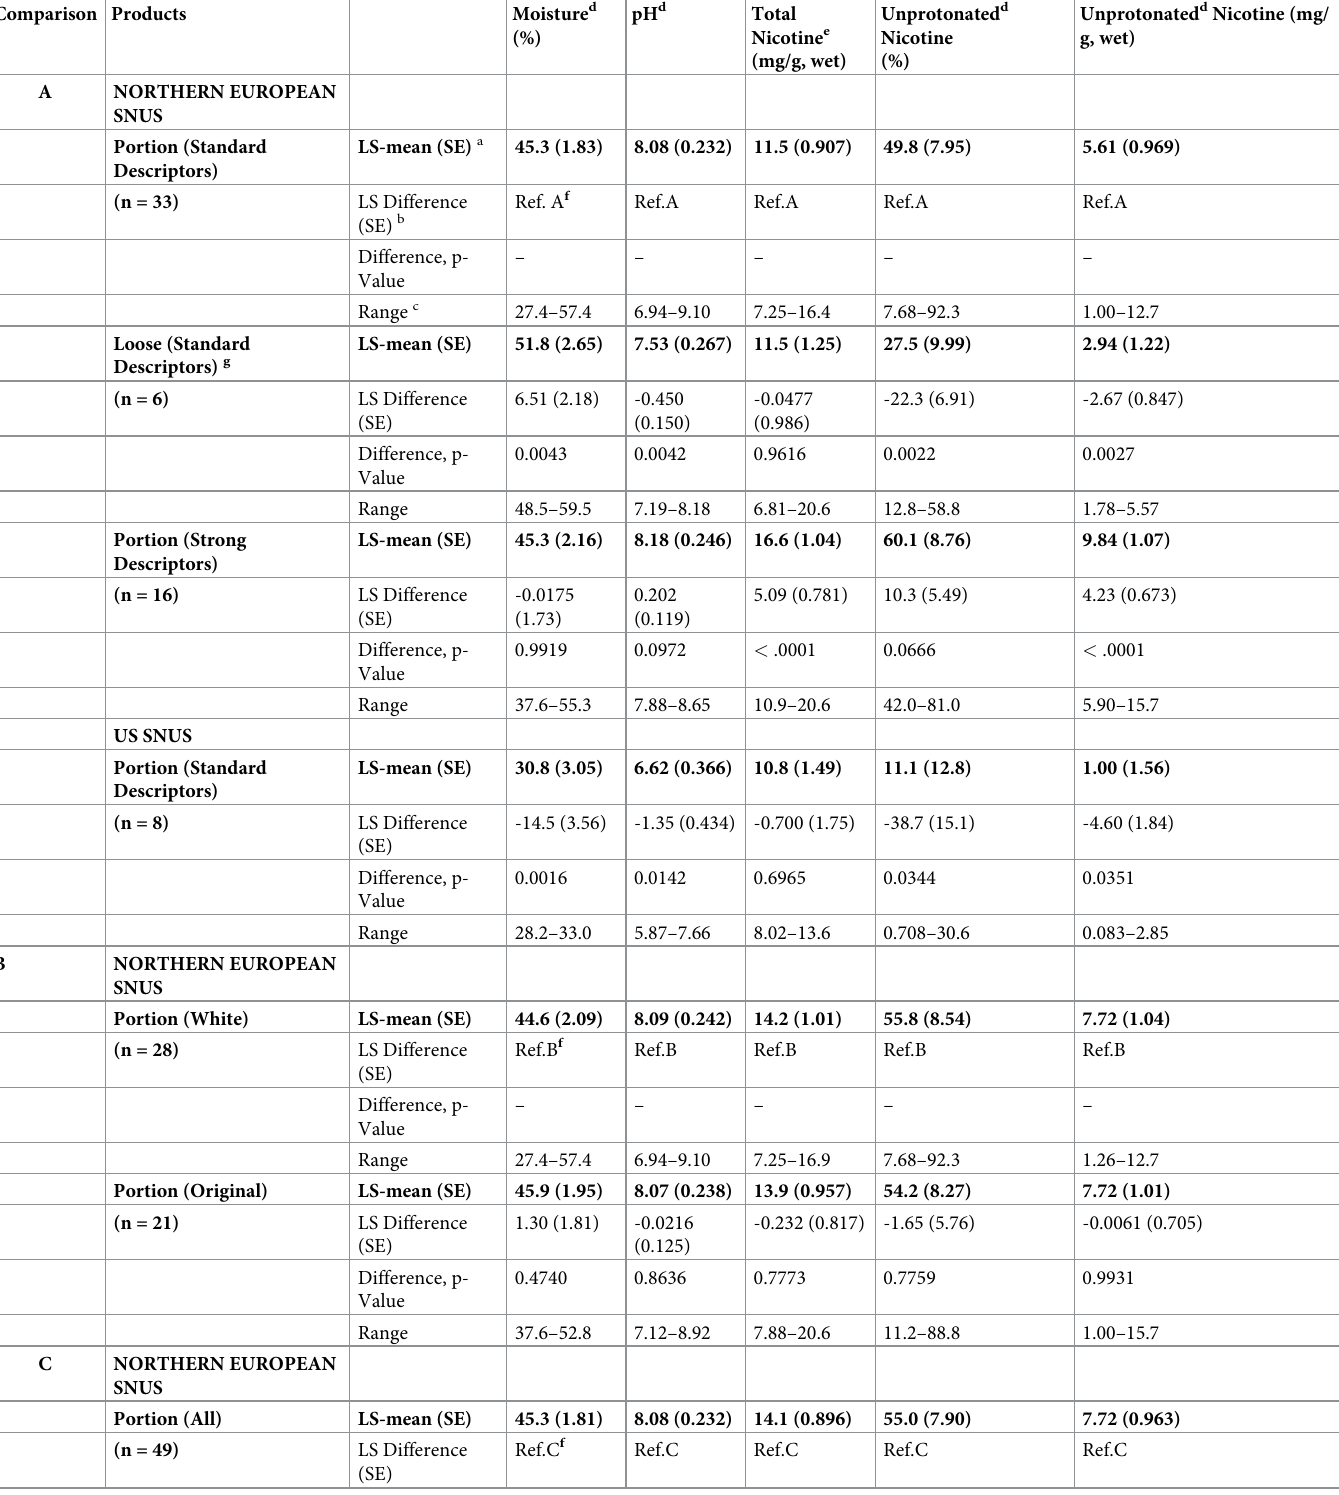
Table 1. Least-square means of moisture, pH, and nicotine concentrations for snus categorized by region and product type. Comparison